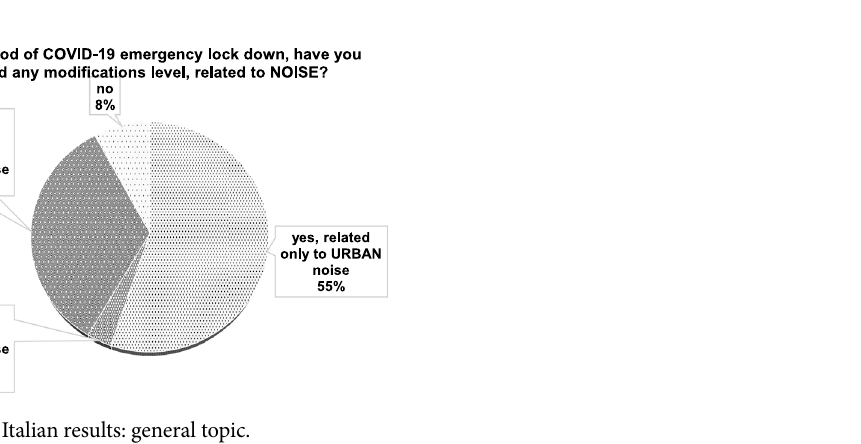
Figure 4. Respondents’ geographical distribution. Red spots roughly identify state of provenance (map 41 freely modified using Microsoft Word).